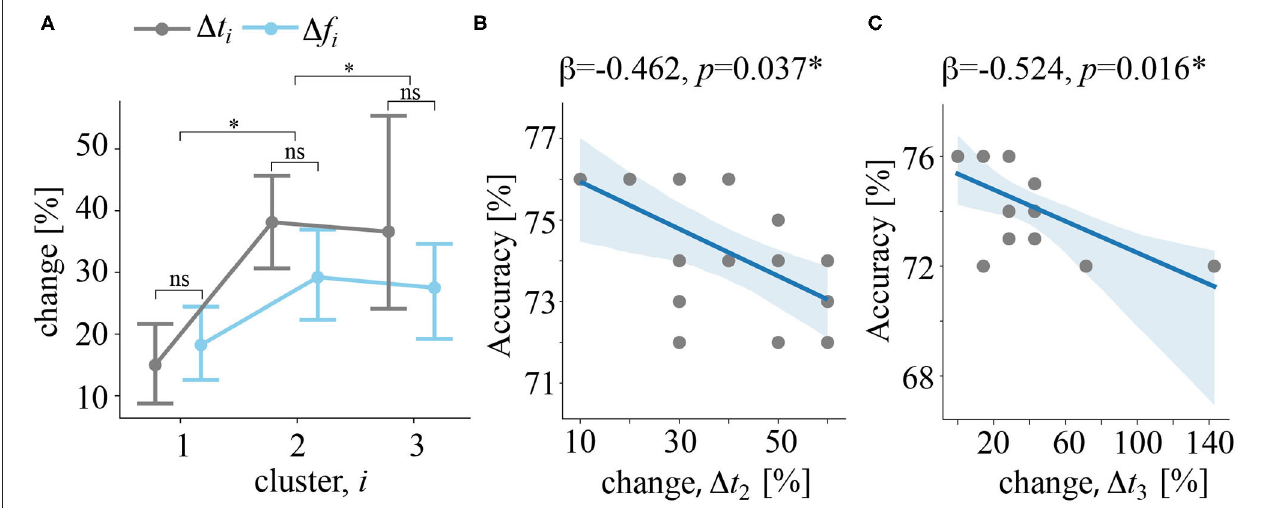
FIGURE 6 | (A) 1 f i and 1 t i quantify how the frequency and the time band changed when excluding a particular subject from the feature selection procedure, i is the cluster number. Data are shown as the group mean and 95 % confidence interval, ∗ p < 0.05, and ns p > 0.05 via ANOVA and a post-hoc t -test. (B) The regression plot reflects the negative correlation between changes in the time band for cluster 2 and CNN classification accuracy. (C) Regression plot reflects the negative correlation between changes in the time band for cluster 3 and CNN classification accuracy. Dots show the data of single subjects. The solid line is a regression model. The shadow area illustrates the 95 % confidence